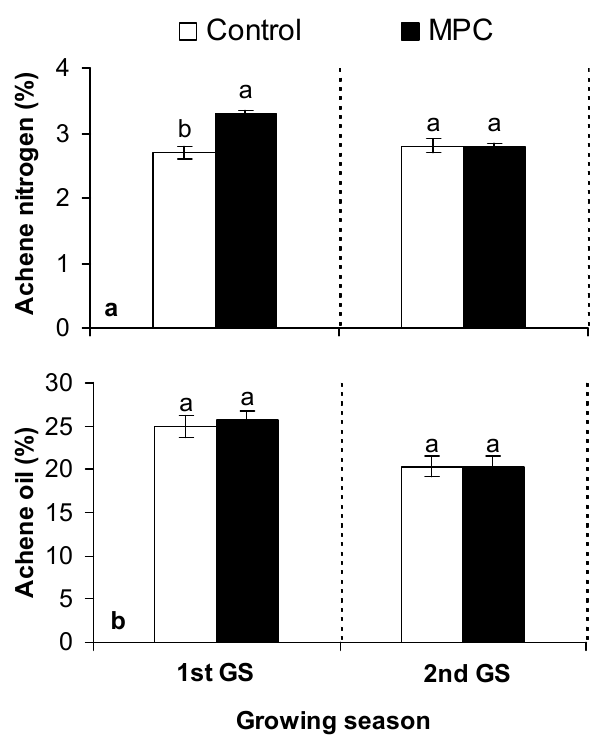
Figure 7. Achene nitrogen content ( a ) and achene oil content ( b ) of sunflower plants as influenced by foliar treatments of MPC (37.5 + 37.5 g ha − 1 in the 1st growing season (GS) and 37.5 + 37.5 + 37.5 g ha − 1 in the 2nd GS). Different letters within each GS show statistically significant differences at p < 0.05 and vertical bars denote standard errors of means ( n = 12). MPC, mepiquat chloride.